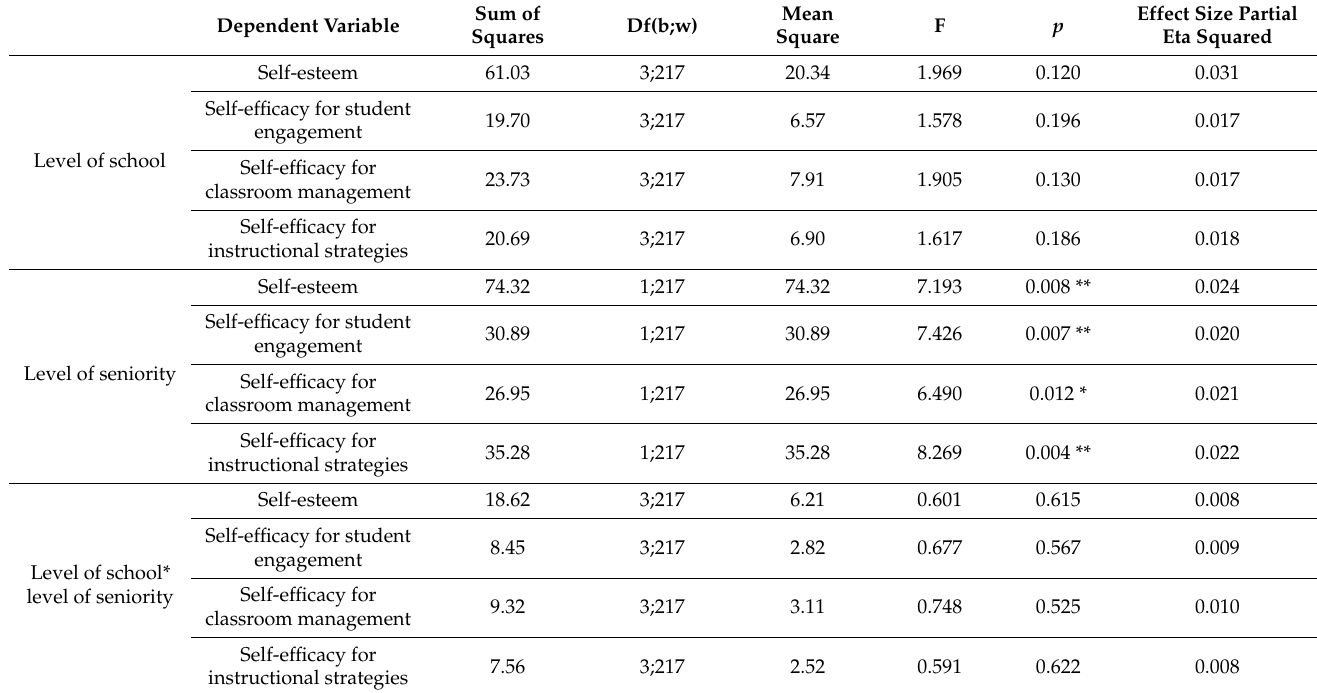
Table 4. Manova—Univariate Tests.